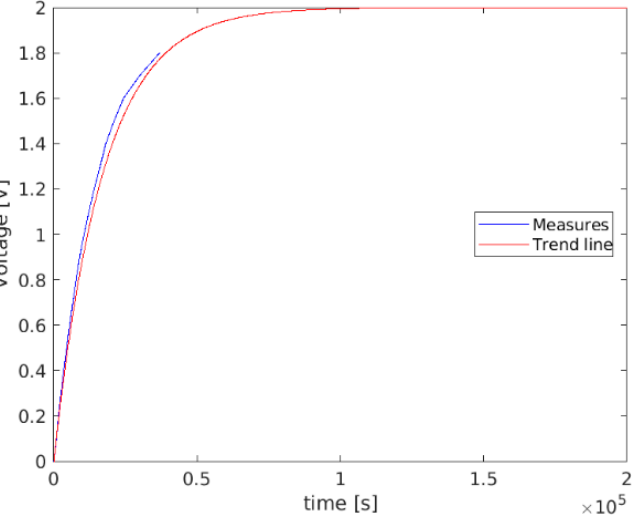
Figure 15. Waveforms of the charge time of the 10 F super capacitor with only one piezoelectric device.